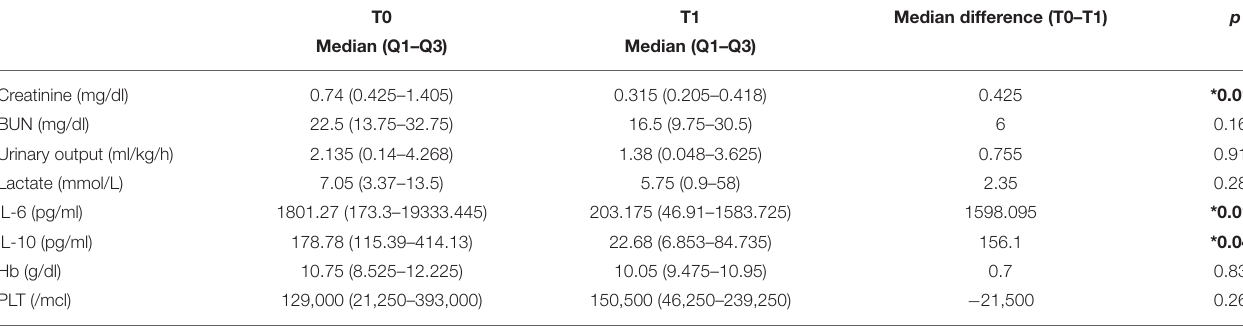
TABLE 2 | Statistical evaluation of renal outcome parameters before (T0) and after (T1) hemoperfusion with CytoSorb. T0 T1